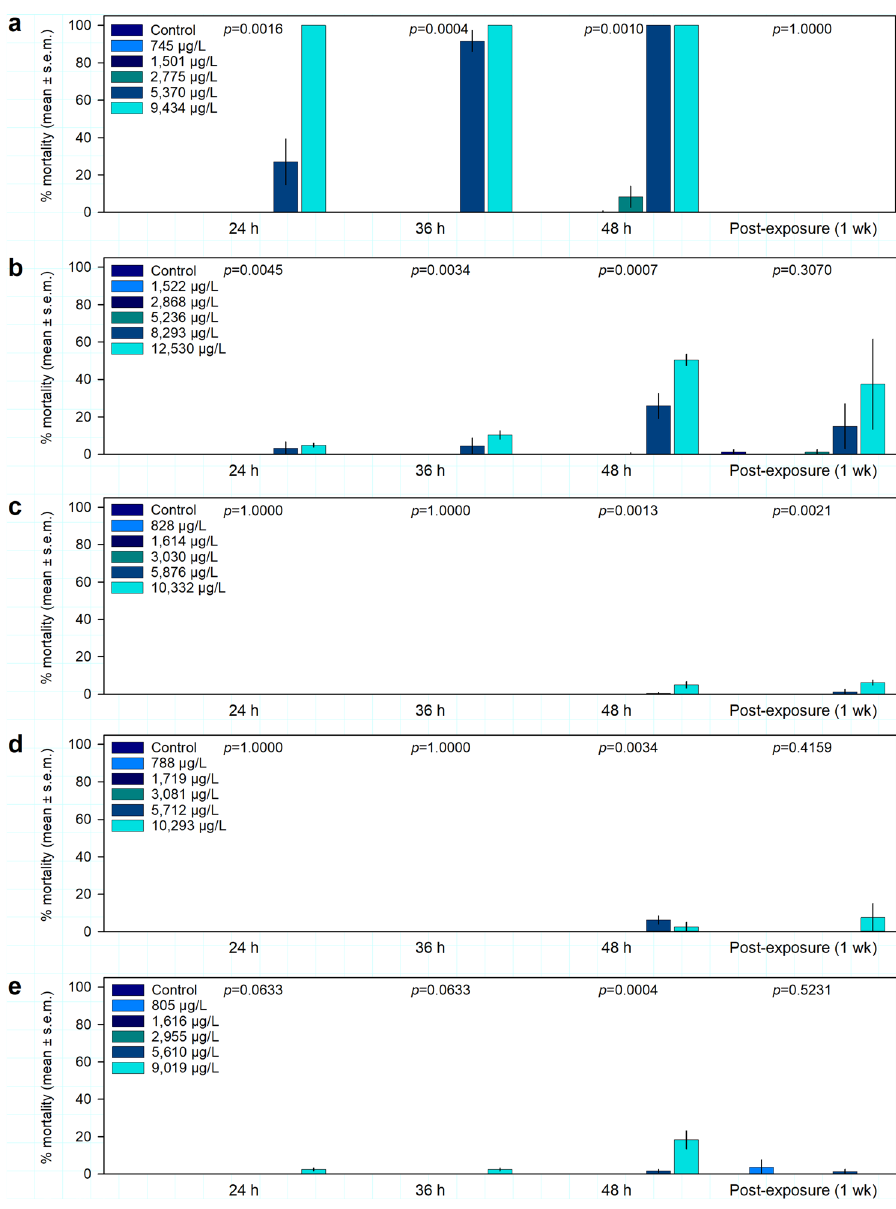
Figure 4. Coral percent mortality (mean ± s.e.m.) (n = 4 replicates) during 1-methylnaphthalene exposures at 24 h, 36 h, 48 h of exposure and at 1 week post-exposure. ( a ) Acropora cervicornis , ( b ) Porites astreoides , ( c ) Siderastrea siderea, ( d ) Solenastrea bournoni , and ( e ) Stephanocoenia intersepta